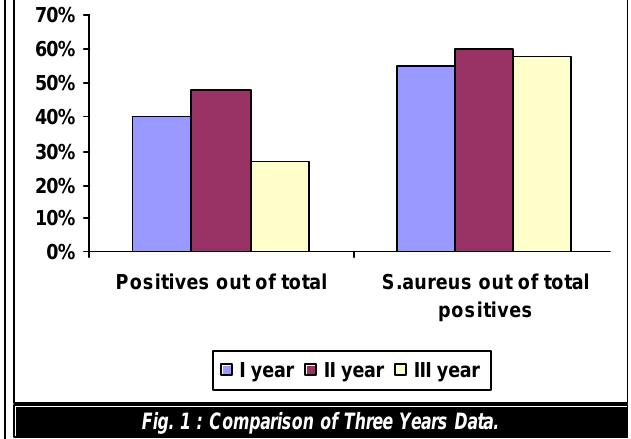
Fig. 1 : Comparison of Three Years